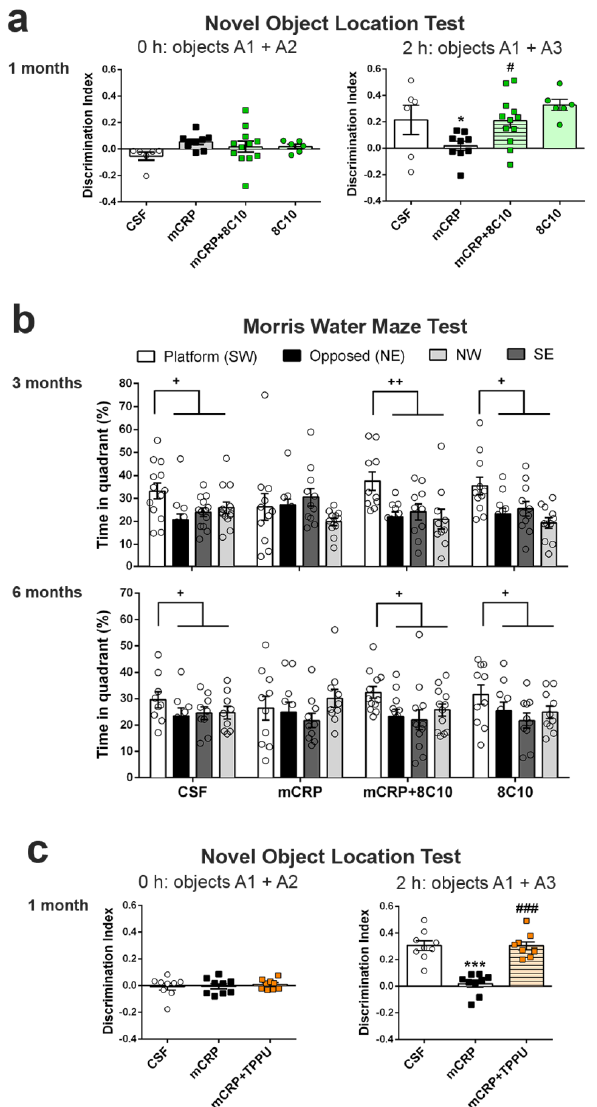
Figure 4. Long-term loss of spatial memory induced by mCRP was prevented by 8C10 antibody. Exposure to mCRP induced total loss of spatial memory, which was prevented by 8C10, as shown by the Novel object location test in the 1-month assessment ( a ) and by the Morris water maze test in the 3 and 6-month assessments ( b ). ( c ) TTPU similarly protected against loss of spatial memory after 1 month of exposure to mCRP, as shown by the Novel object location test. Values are mean ± SEM (( a ) CSF N = 6, mCRP N = 9, mCRP + 8C10 N = 12 and 8C10 N = 6; ( b ) 3 months, CSF N = 13, mCRP N = 11, mCRP + 8C10 N = 10 and 8C10 N = 11; 6 months, CSF N = 9, mCRP N = 10, mCRP + 8C10 N = 12 and 8C10 N = 10. ( c ) CSF N = 9, mCRP N = 9 and mCRP + TPP N = 9). Statistics: * p < 0.05, *** p < 0.001, compared to Control group; # p < 0.05, ### p < 0.001 compared to mCRP group; + p < 0.05, ++ p < 0.01, Platform quadrant compared to the average of the other quadrants. For the confirmation of the protective effects of 8C10 after 3 and 6 months of treat- ment with mCRP, spatial memory was analyzed using the widely known test of MWM instead of OLT. Results of the MWM for the 3- and 6-month studies showed a loss of spatial memory in the mCRP group and total preservation in the mCRP + 8C10 group